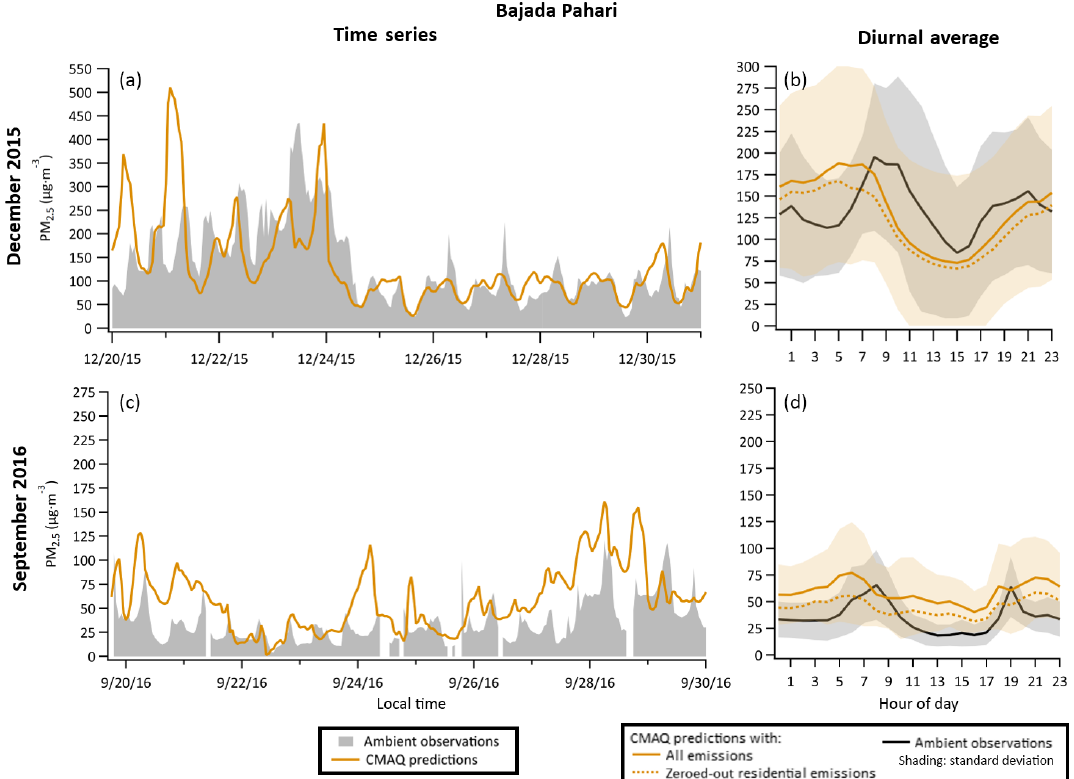
Figure 6. Measured and predicted PM 2 . 5 (a, c) and average diurnal cycle (b, d) in Bajada Pahari for 20–31 December 2015 (a, b) and 20–30 September 2016 (c, d) . Here the yellow lines correspond to CMAQ predictions of the “total” (solid) and “nonresidential” (dotted) simulations. The solid black line represents ambient observations. Standard deviations of the diurnal profiles for observations and predictions are indicated, respectively, by colored shading. Diurnal profiles were averaged over simulation durations (Table 7). Computations were carried out at 4km